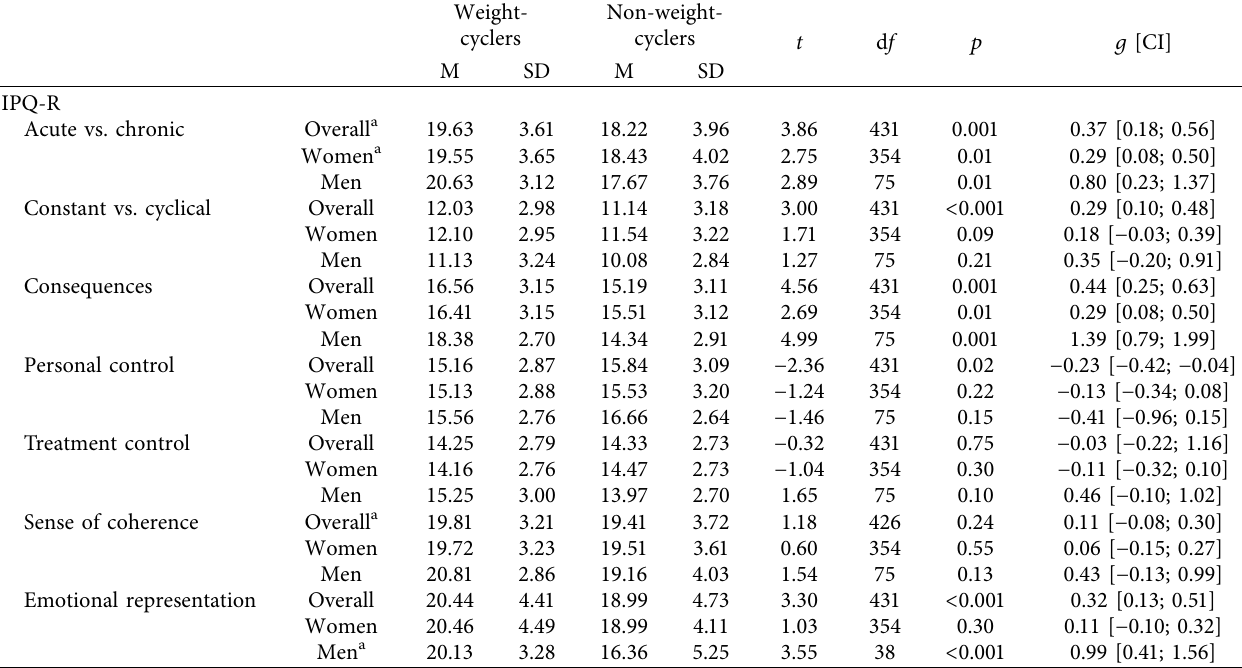
Table 3: Differences in subjective illness representations depending on